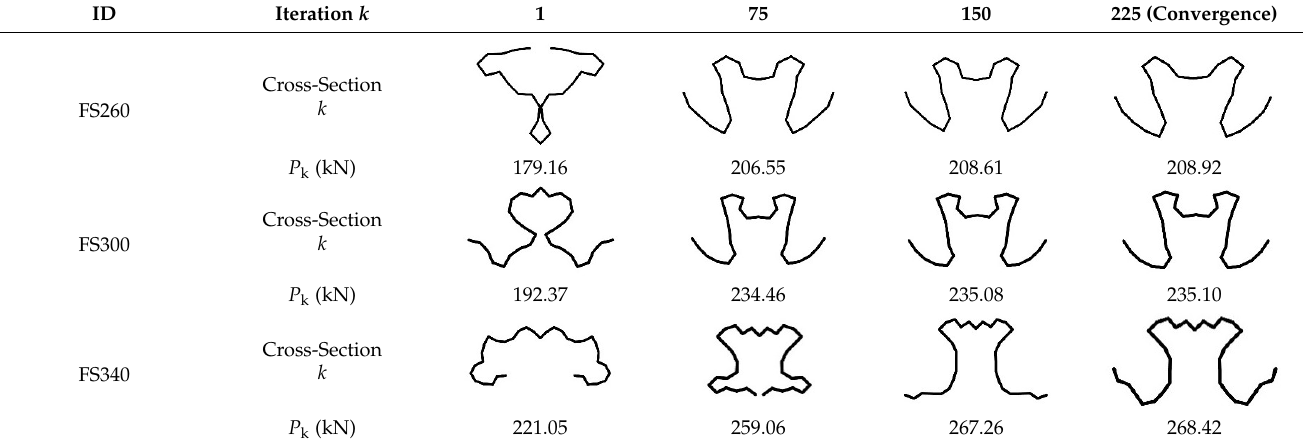
Table 3. Parameters of C cross-section.